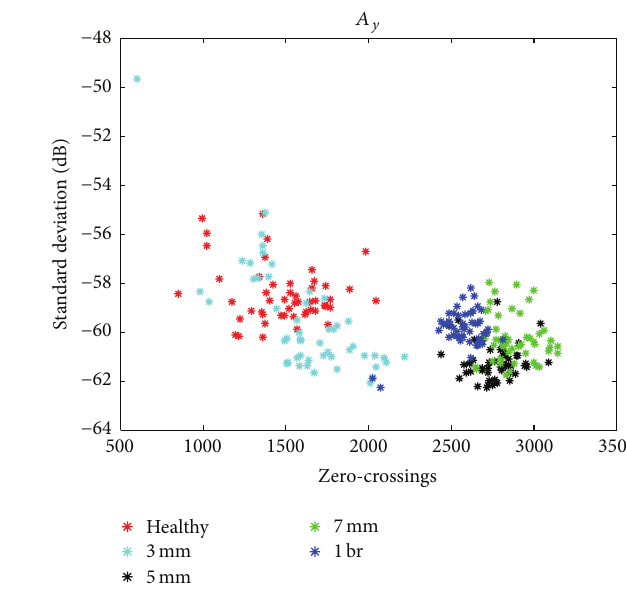
Figure 12: Half-load condition analysis, 𝐴 𝑦 -axis.